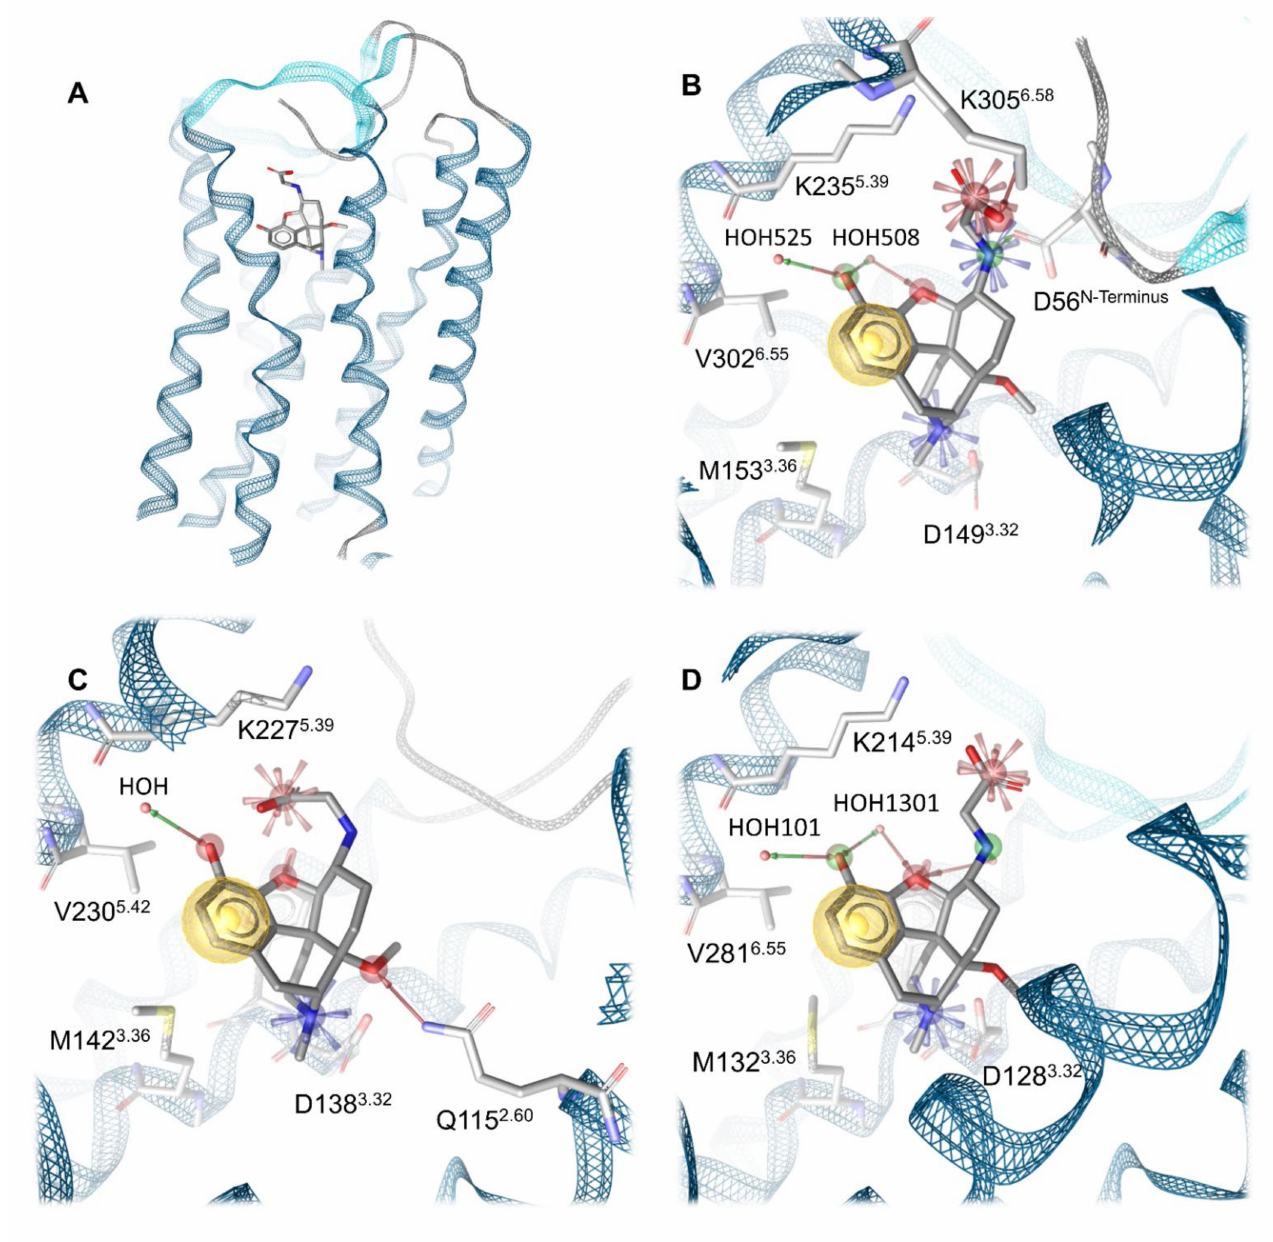
Figure 5. Binding modes of HS-731 to the classical opioid receptors. ( A ) Global view on the MOR binding pocket with docked HS-731. ( B ) Binding pocket of the MOR. Residues 297–303 and 322–325 are not shown for better visualization. ( C ) Binding pocket of the KOR. Residues 289–294 and 311–318 are not shown for better visualization. ( D ) Binding pocket of the DOR. Residues 275–282 are not shown for better visualization. Blue star indicates positive ionizable interactions, red stars negative ionizable interactions, yellow spheres lipophilic contacts, green arrow hydrogen bond donors and red arrows hydrogen bond acceptors. Water molecules are depicted as red